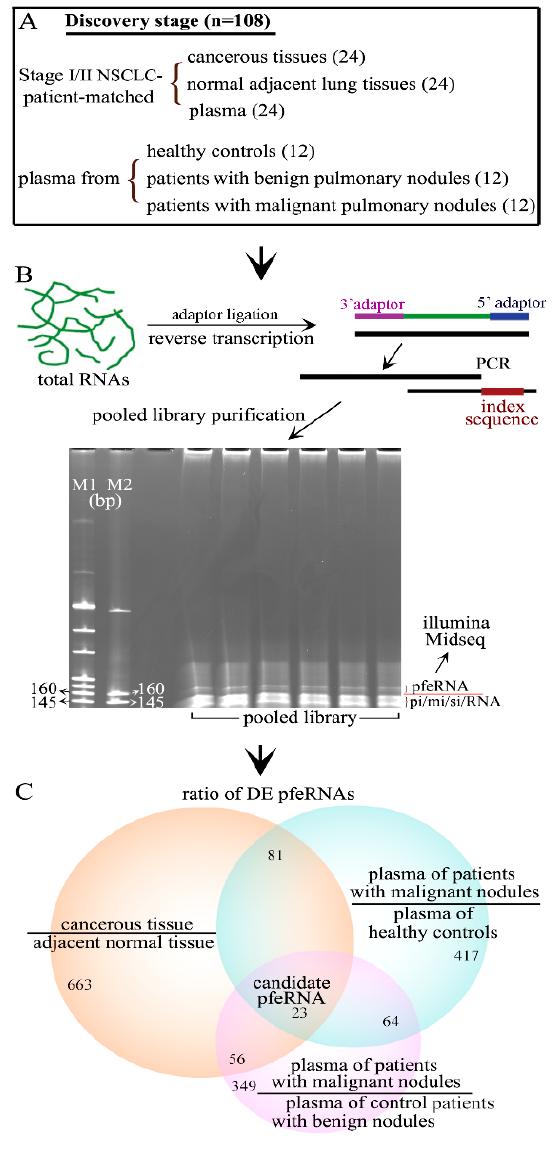
Figure 1. Identifying non-invasive pfeRNA candidates in plasma. ( A ) Biospecimens used in the discovery stage. Upper: 72 patient-matched biospecimens, including cancerous tissues, normal adjacent tissues, and plasma, were from 24 patients with stage I/II NSCLC. Bottom: 36 plasma biospecimens were from 12 healthy controls, 12 patients with benign pulmonary nodules, and 12 patients from malignant pulmonary nodules. ( B ) The preparation process of a pfeRNA library for illumine Midseq. ( C ) Bioinformatics and biostatistics analysis of the differentially expressed (DE) pfeRNAs in different groups. Table 2. Sequences of pfeRNAs and their distribution in chromosomes